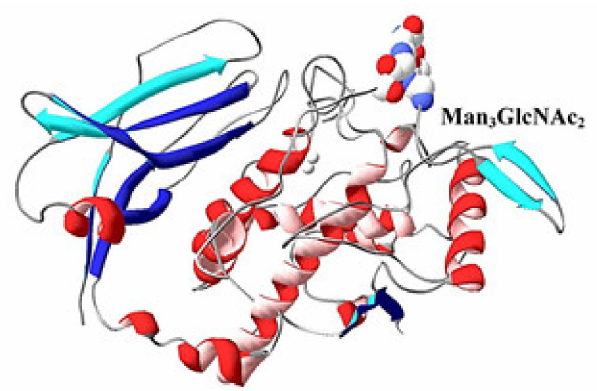
Figure 19. 3D-model of FU RvH-c, depicted on the basis of the structure of the hemocyanin from Octopus dofleini [41]. Glycan, attached to the polypeptide chain of FU-c